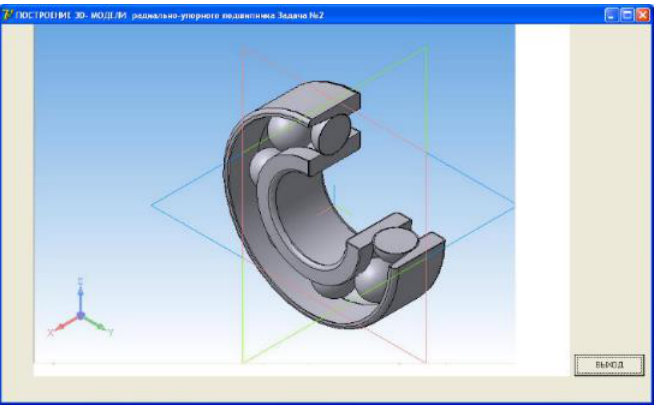
Fig. 5. Examples of implementation of the task in the automated design system. Task 2. Geometrical modeling. It is proposed to develop a program for modeling and converting geometric objects using visual programming